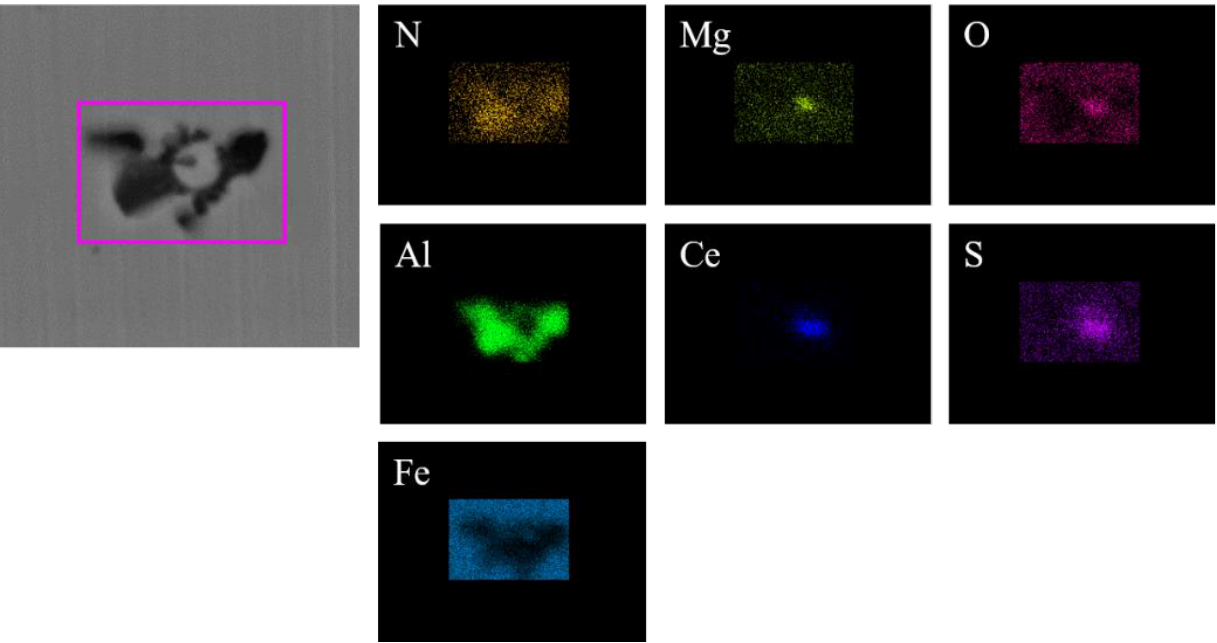
Figure 9. Elemental mapping of a typical inclusion in the steel with 30 ppm Ce content.